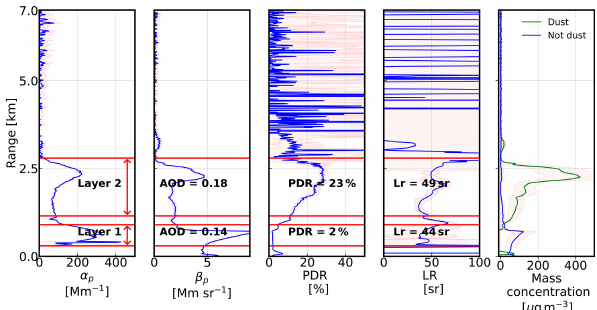
Figure 11. Before the passage of the warm front. Optical properties and mass concentration estimates calculated from averaged profiled from Watnall on 15 October from 18:15 to